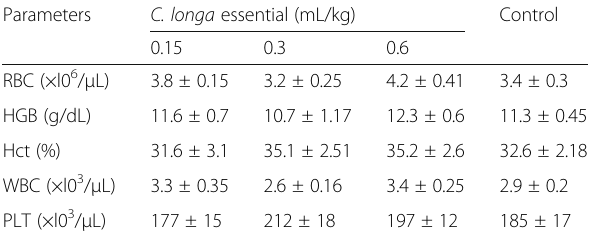
Table 4 Hematology parameters in whole blood of mice following oral administration of C. longa essential oil for 2